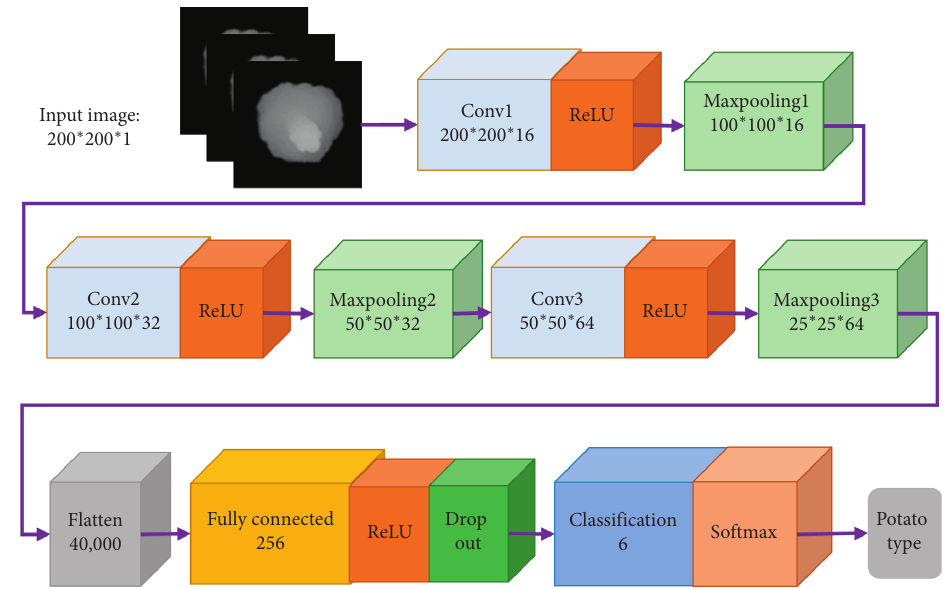
Figure 5: CNN model